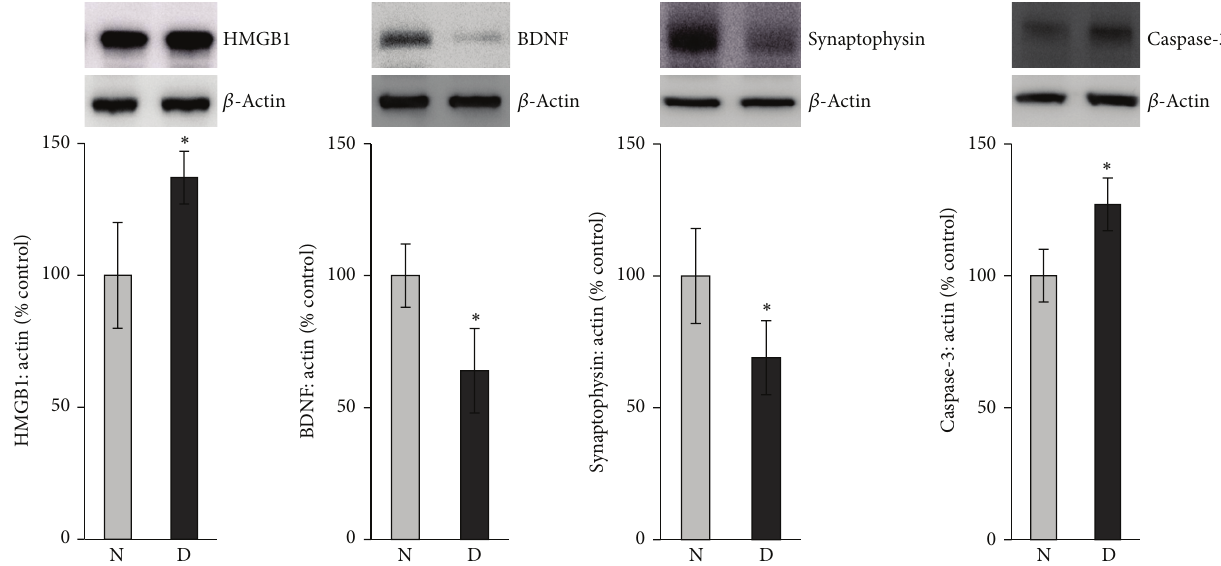
Figure 4: Western blot analysis of high-mobility group box-1 (HMGB1), brain-derived neurotrophic factor (BDNF), synaptophysin, and cleaved caspase-3 in rat retinas. There is a significant increase in the expression of HMGB1 and cleaved caspase-3 and a significant decrease in theexpressionofBDNFandsynaptophysinintheretinasofdiabeticrats(D)comparedwiththenondiabeticcontrolrats(N).Eachexperiment was repeated 2 to 3 times with fresh samples ( 𝑛 = 6 ).